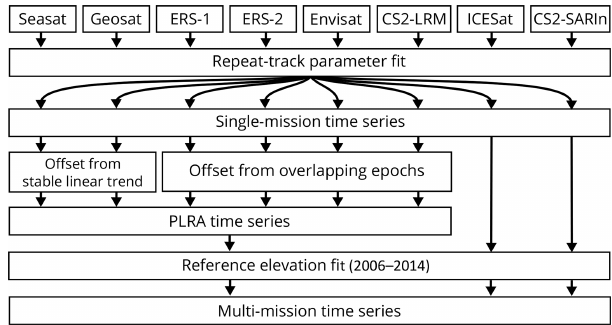
Figure 4. Schematic diagram of the processing steps from the com- bined repeat-track parameter fit over single-mission time series to- wards a combined multi-mission time series.